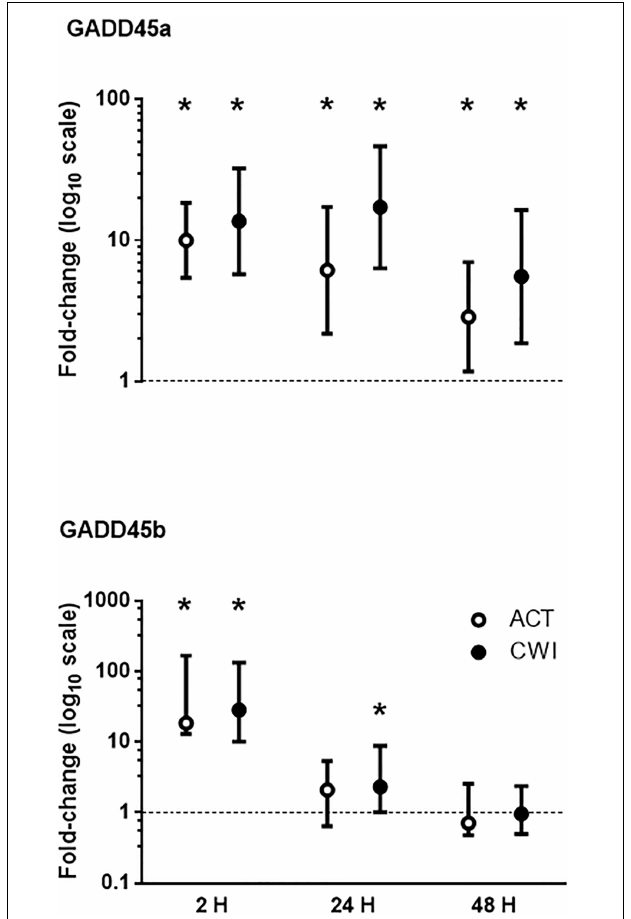
FIGURE 2 | Post-exercise changes in mRNA expression of growth arrest and DNA damage-inducible protein alpha (GADD45a) and GADD45 beta (GADD45b). Data are presented as changes in the geometric mean ± 95% confidence interval of the geometric mean for GADD45A, and the median ± interquartile range for GADD45B. * P < 0.05 versus pre-exercise. ACT, active recovery; CWI, cold water immersion. The dotted line represents a nominal pre-exercise value of 1.0 (for